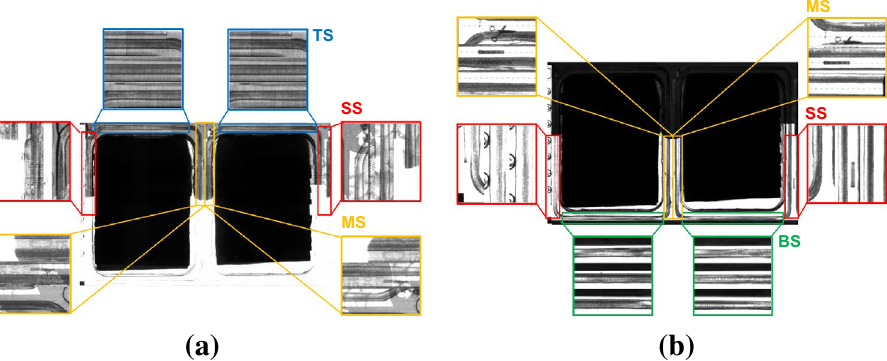
Figure 8. Images from the sealing mosaic dataset according to the different parts of the sealing that have been considered for the evaluation of the model in light ( a ) and dark ( b ) images (TS, BS, SS and MS correspond to top, bottom, side and middle sealing,